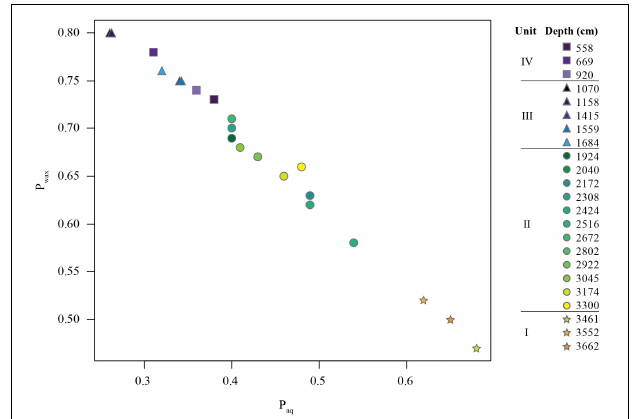
FIGURE 7 | n -Alkane proxies for aquatic (P aq ) vs. terrestrial (P wax ) plant input of Goltsovoye Lake sediment core PG2412. Unit I: orange stars, Unit II: green circles, Unit III: blue triangles, Unit IV: purple